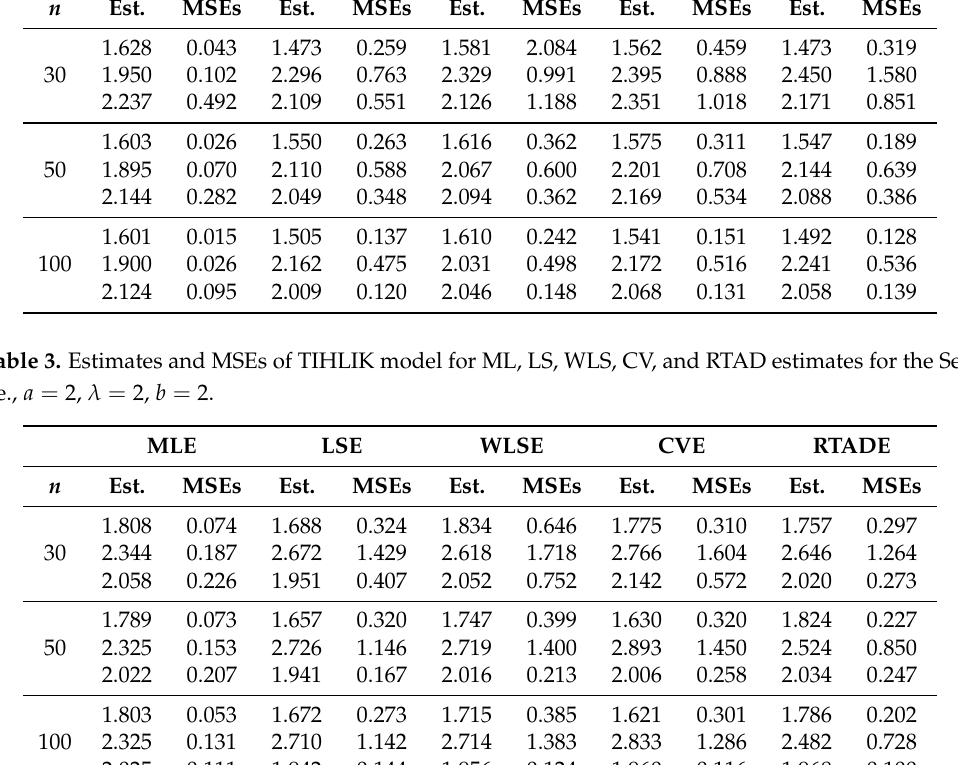
Table 2. Estimates and mean square errors (MSEs) of TIHLIK model for maximum likelihood (ML), least squares (LS), weighted least square (WLS), Cramer-von Mises minimum distance (CV), and right-tail Anderson–Darling (RTAD) estimates for the Set1, i.e., a = 1.5, λ = 2, b = 2. MLE